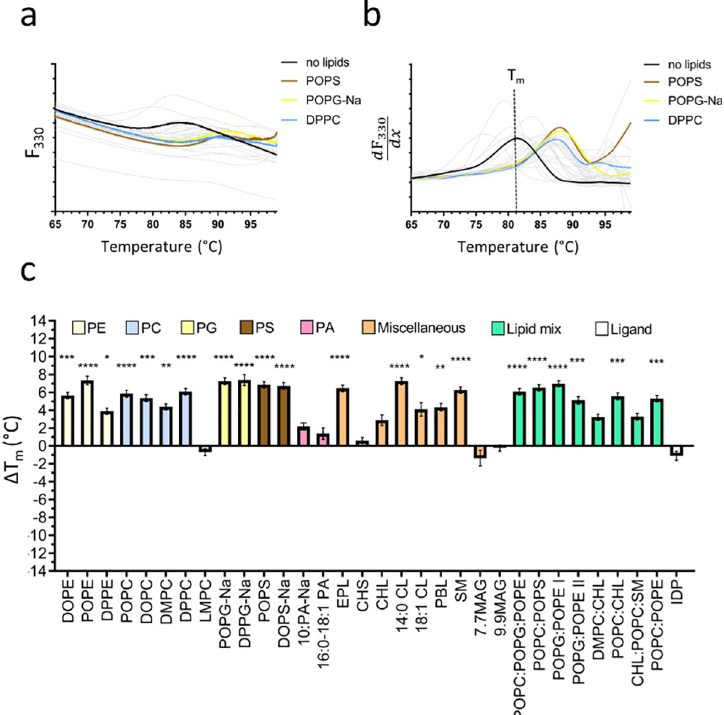
Fig 3. Lipid screening of Tm -PPase by nanoDSF. ( a ) F 330 signal of the no lipids reference sample (black line) and a representative set of stabilising lipids (coloured lines) during the melting scan. Grey lines show the fluorescence traces of the other tested lipids. ( b ) First derivative of the F 330 signal highlighting the fluorescence change indicative of protein unfolding. The T m can be determined at the curve peak, here shown for the no lipids reference sample as dotted line. ( c ) Δ T m of detergent-solubilised to relipidated sample shown for all tested lipids, which are sorted and colour coded according to their lipid class. Panel a-b show the traces of a representative nanoDSF scan. Panel c shows the Δ T m and corresponding SEM based on three technical repeats. The asterixis represent the p-value ( � = 0.0332, �� = 0.021, ��� = 0.002, ���� = 0.0001) obtained by a one-way ANOVA followed by a Dunnet test to correct for multiple comparison in GraphPadPrism